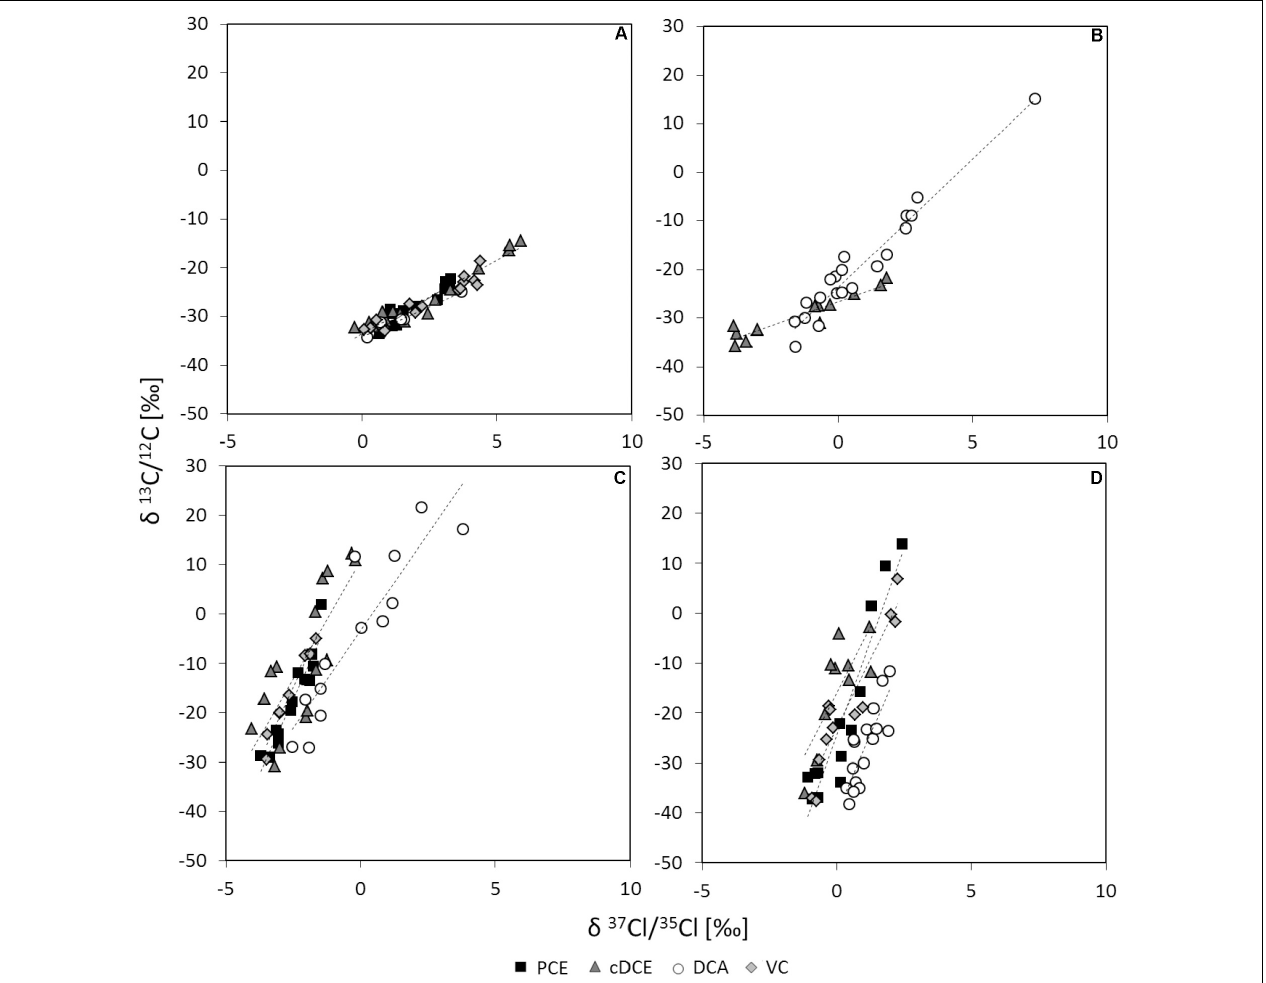
FIGURE 2 | Double-element-plots for stable carbon and chlorine isotope fractionation. Activity assays using resting cells of D. mccartyi strain BTF08 with electron acceptors (A) PCE, (B) 1,2-DCA, (C) cDCE or (D) VC in dependence of the electron acceptors used for growth in upscaled transfer 1. Linear fits are represented by dashed